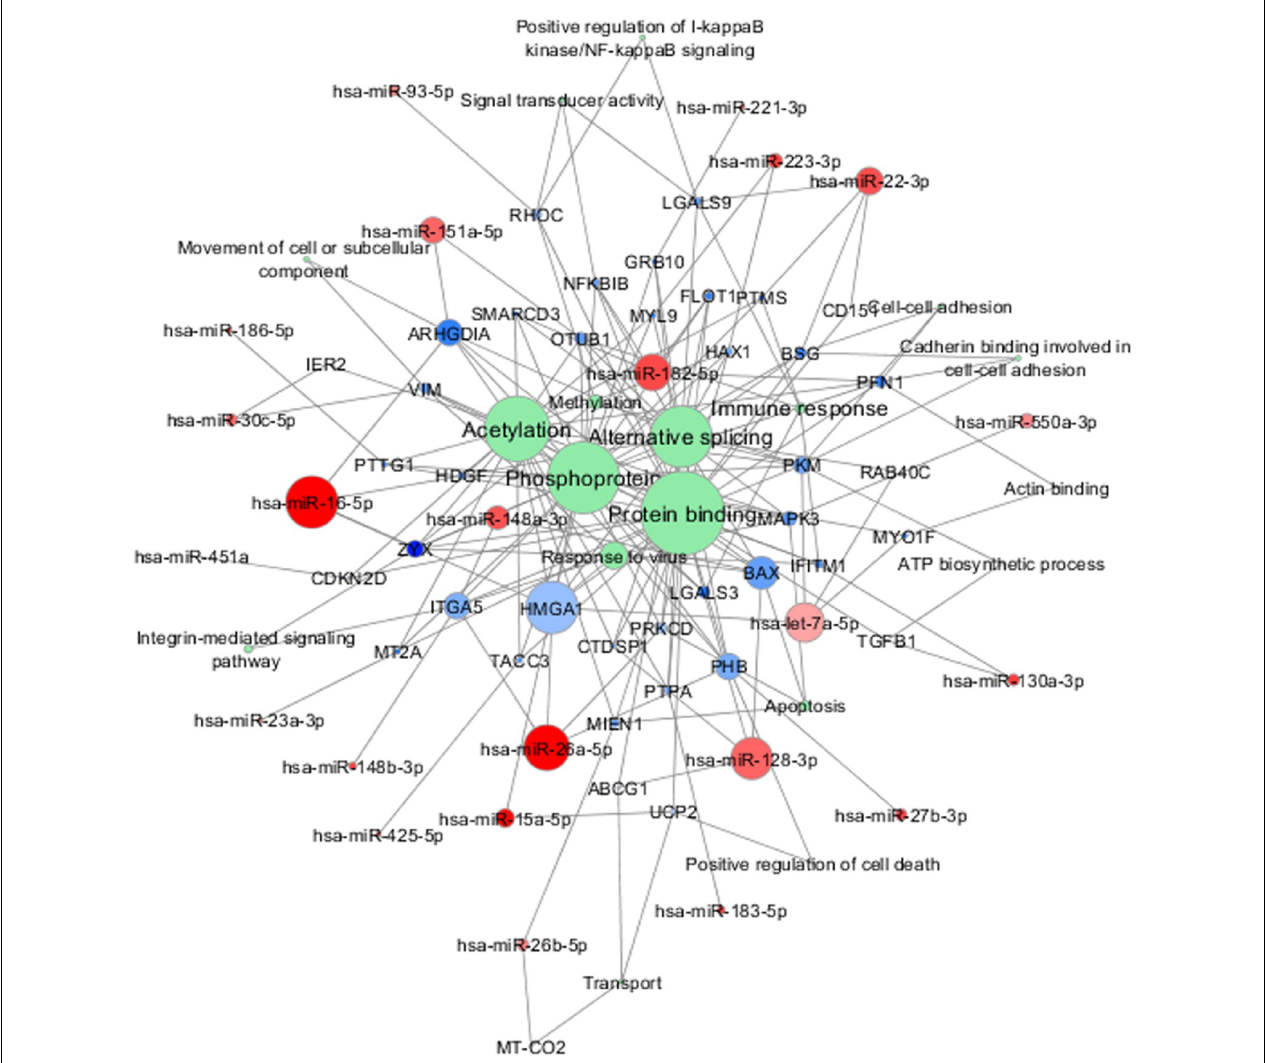
FIGURE 6 | Combined molecular analysis in sALS. Functional annotations of experimentally validated target genes together with their miRNAs are visualized as a network (Cytoscape 3.6.0). Each node size is proportional to the degree of the node (connectivity). Green nodes correspond to functional annotations obtained by functional enrichment analysis (DAVID tool). Color gradient intensity of miRNA and target nodes correlates with upregulated ( blue ) or downregulated ( red ) expression levels.